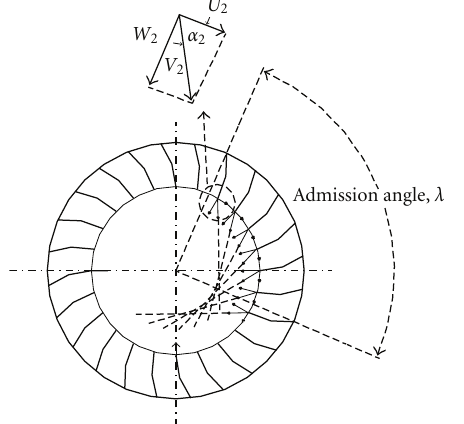
Figure 2: Streamlines intersection at 1st stage outlet of the Banki turbine.